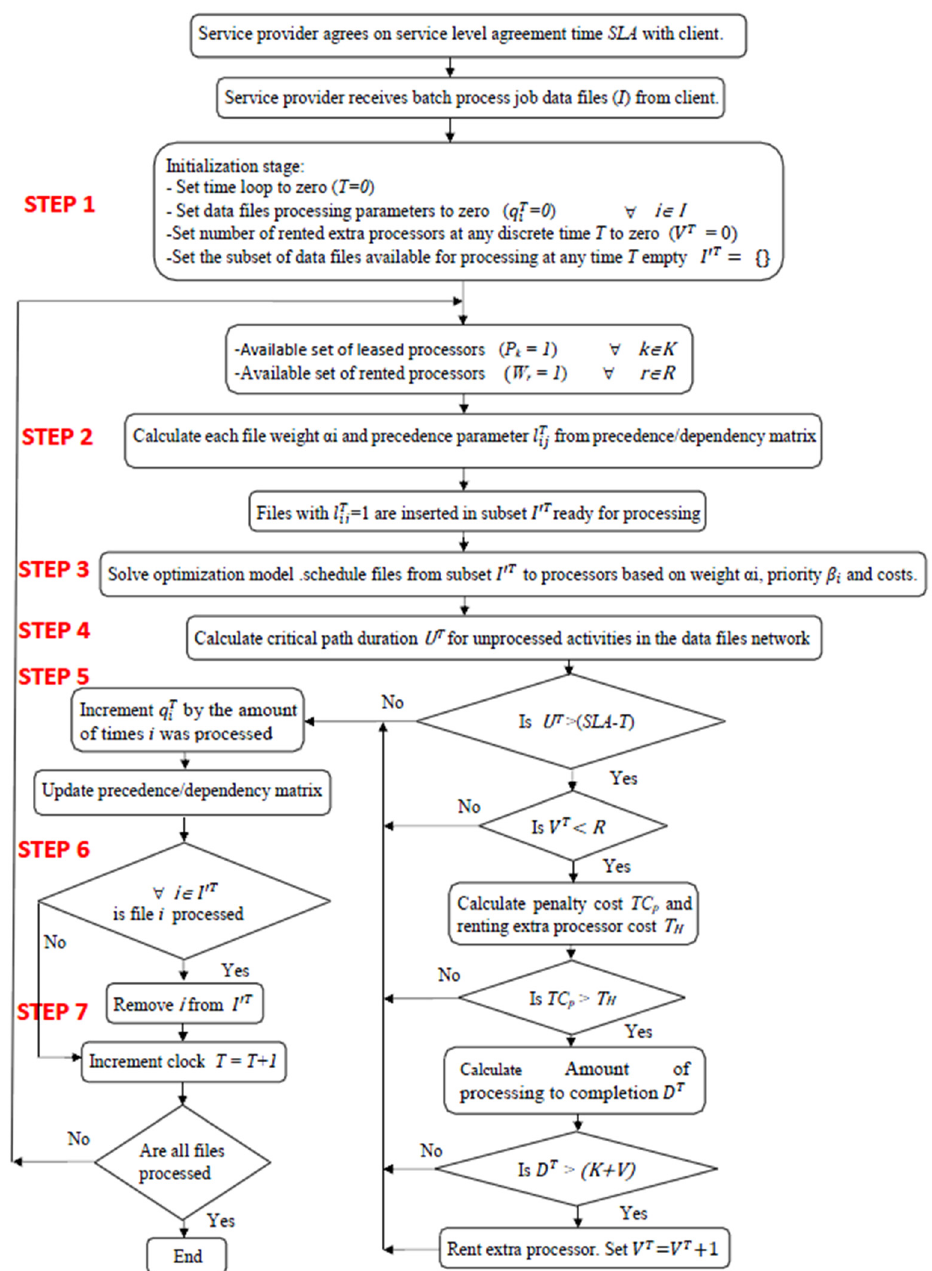
Figure 2. Dynamic Cost Scheduling Algorithm for Data Batch Processing (DCSDBP).